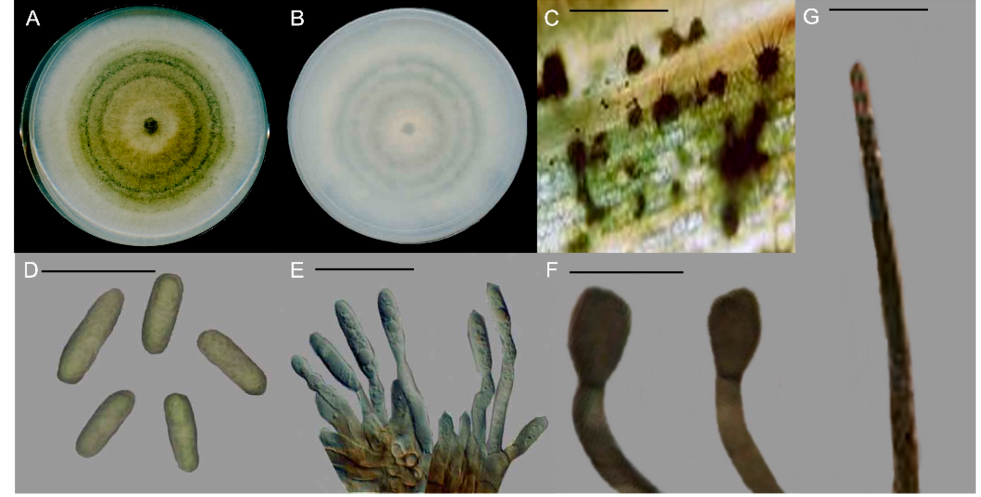
Figure 2. Morphological characteristics of Colletotrichum truncatum . ( A ) Colony appearance. ( B ) Pigmentation. ( C ) Acervuli. ( D ) Conidia. ( E ) Conidiogenous cell. ( F ) Appressoria. ( G ) Seta. Scale, ( C , E , G ) = 20 μ m & ( D , F ) = 50 μ m.